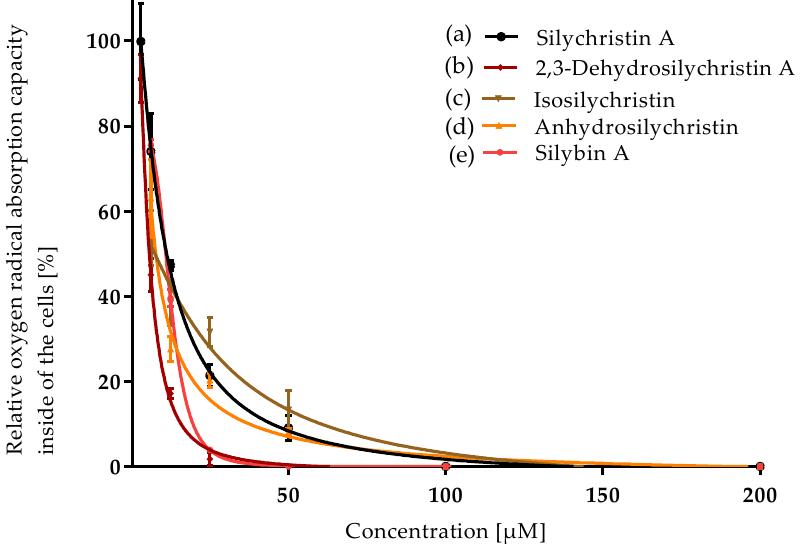
Figure 3. Relative oxygen radical absorption capacity of silychristin derivatives in cellular antioxidant activity assay (CAA, HepG2 cells): ( a ) silychristin A; ( b ) 2,3-dehydrosilychristin A; ( c ) isosilychristin; ( d ) anhydrosilychristin; ( e ) silybin A. Data are presented as the average of three measurements with respective standard error of the mean. The Ymax /Ymin values were as follows: ( a ) 100 ± 5/0; ( b ) 91 ± 3/0; ( c ) 54 ± 4/0; ( d ) 63 ± 5/0; ( e ) 76 ± 1/0.